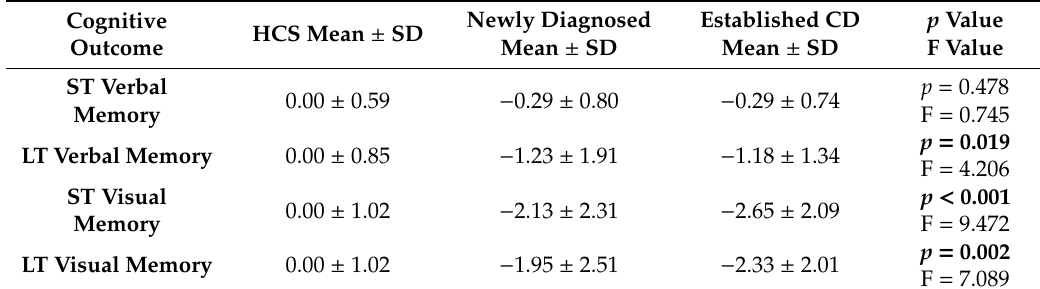
Table 3. Results of additional analyses comparing short-term (ST) and long-term (LT) components of visual and verbal memory between groups.